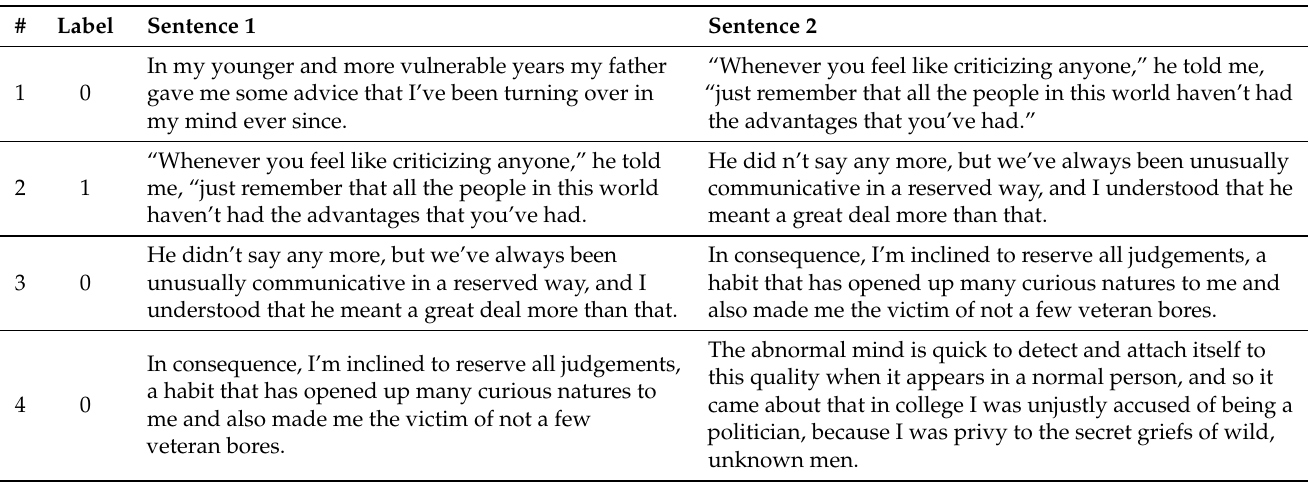
Table 1. Examples of samples in the Fitzgerald dataset. Positive samples in which a paragraph boundary exists between Sentence 1 and Sentence 2 are labeled ‘1’, and negative samples in which a paragraph boundary does not exist between Sentence 1 and Sentence 2 are labeled ‘0’.